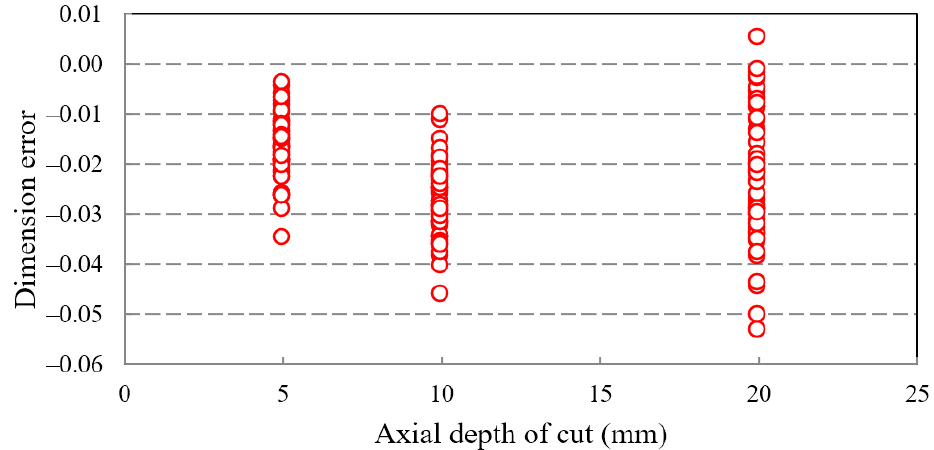
Figure 19. Distribution graph of dimensional accuracy in terms of radial depth of cut.